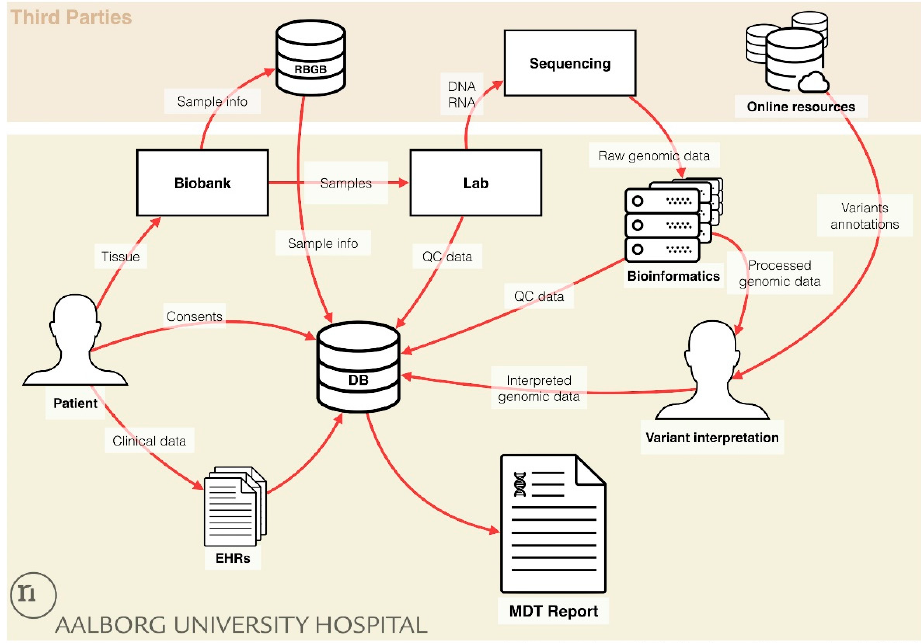
Figure A1. Laboratory Information Management. An overview of the data flow in the ProGen